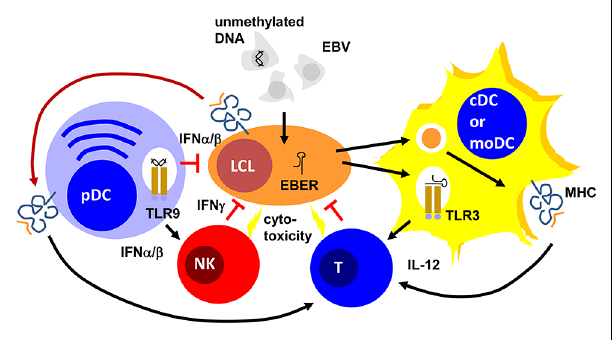
FIGURE 1 | Plasmacytoid, conventional and monocyte-derived DCs might contribute to EBV specific immune control. Unmethylated DNA of EBV particles and EBERs of EBV-infected B cells (LCLs) mature plasmacytoid (pDCs) and conventional or monocyte-derived DCs (cDCs or moDCs) viaTLR9 orTLR3 stimulation, respectively.These mature pDC and cDC or moDC populations activate natural killer (NK) andT cells via type I interferon (IFN α / β ) or interleukin 12 (IL-12) secretion, respectively. ForT-cell stimulation by MHC presentation they acquire EBV antigens either via phagocytosis of dying LCLs (for cDCs and moDCs) or trogocytosis of EBV epitope presenting MHC complexes (pDCs).The activated NK and primedT cells then delay primary EBV infection via IFN γ and kill infected cells. PDCs can also delay primary EBV infection via IFN α / β production.